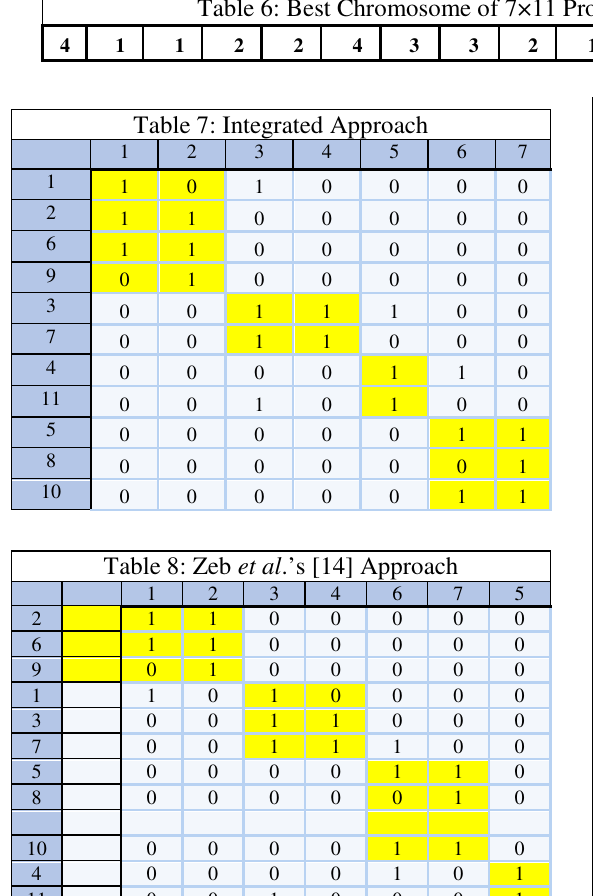
Table 6: Best Chromosome of 7×11 Problem (Boctor, 1991 ) (Zeb et al . (2016)’s Approach)